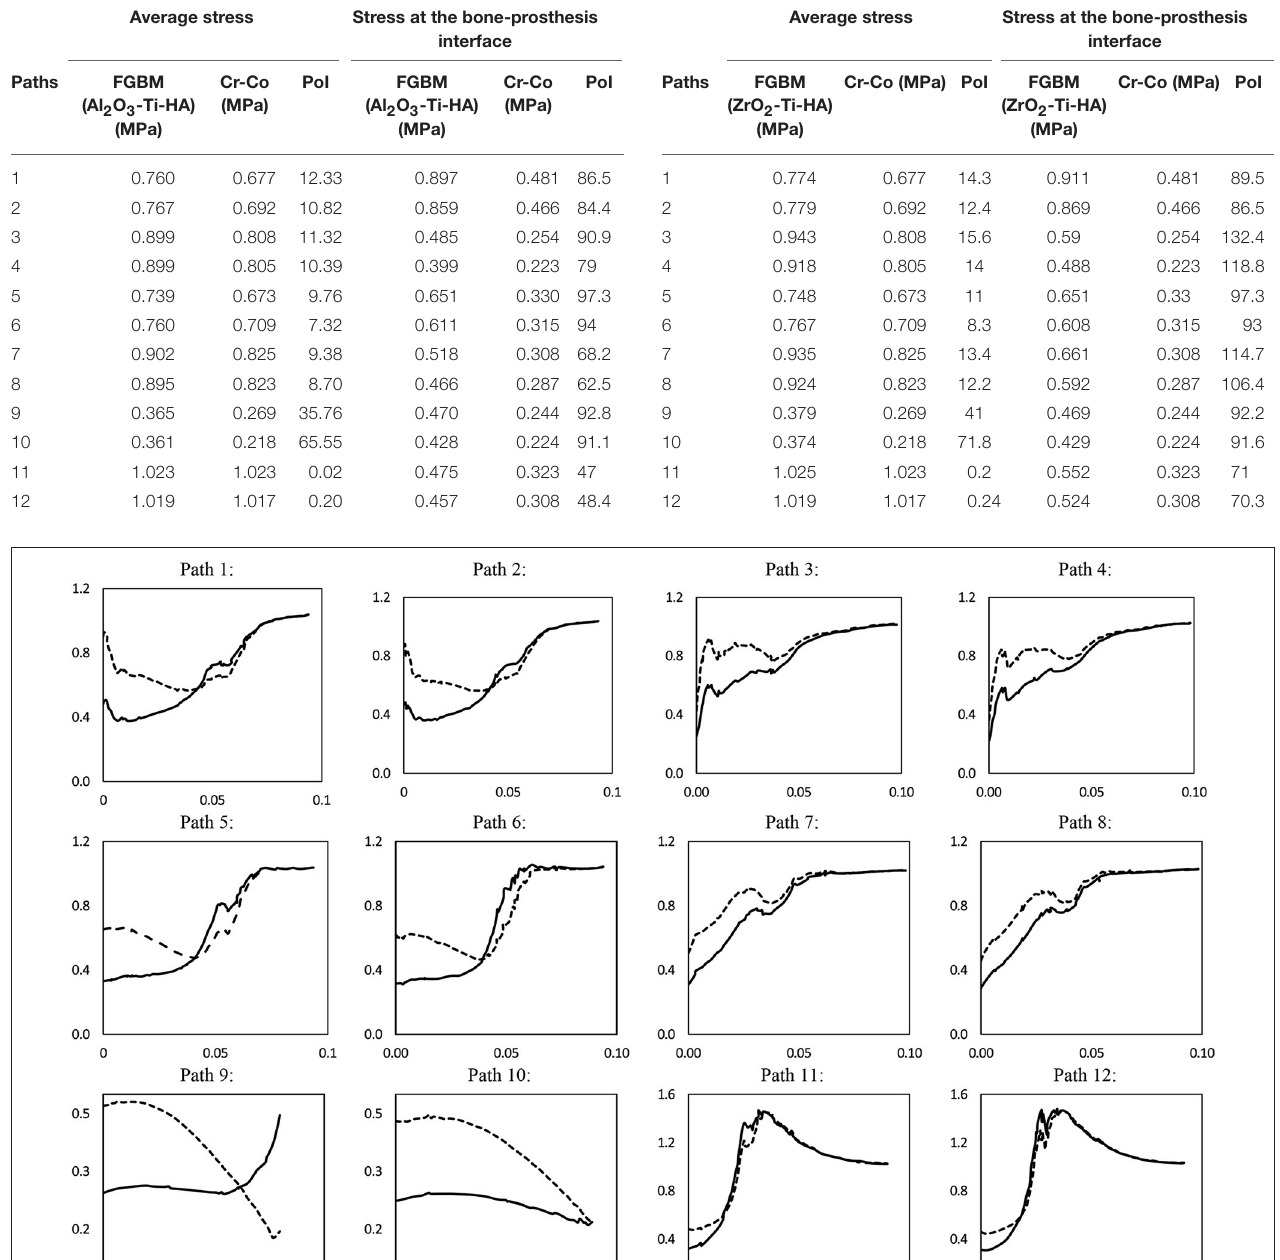
TABLE 2 | Average and bone-prosthesis interface stresses along assumed paths at Cr-Co and alumina-based proposed FG biomaterial [PoI: Percent of increase (%)].